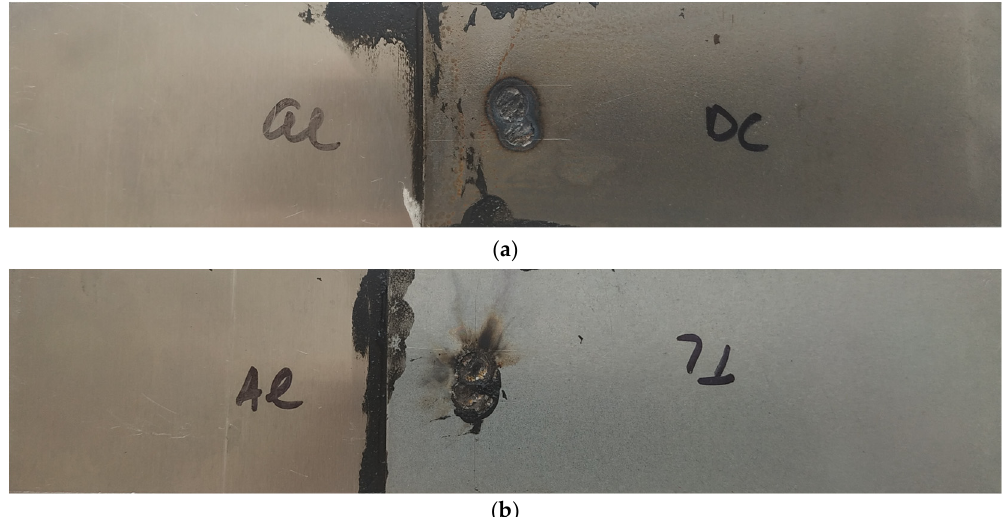
Figure 10. Appearance of test joints made by resistance spot welding and AB: ( a ) Al-DC and ( b ) Al-TL, rubber based adhesive.